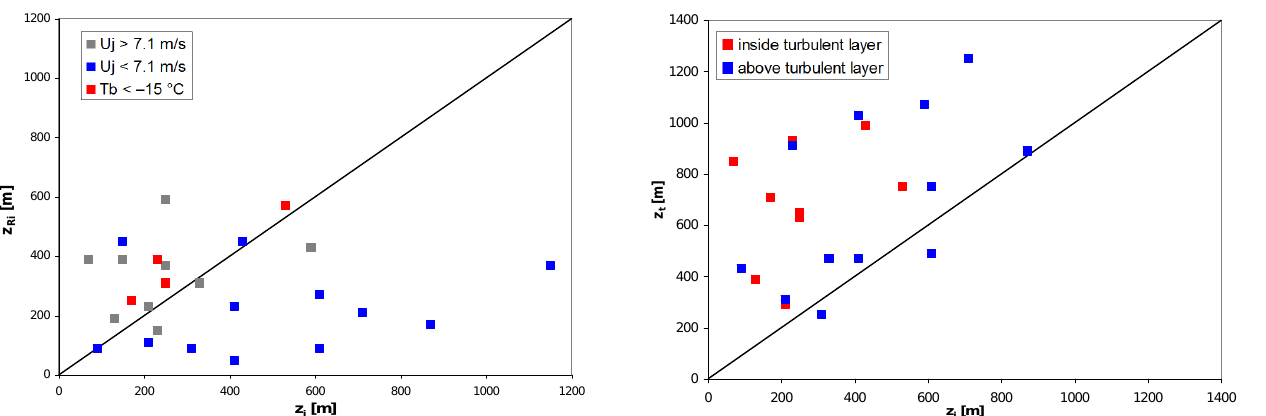
Fig. 8. A comparison of the height of the jet core, z j , with the height of temperature inversion top, z t . LLJs are divided into two groups with the core inside or outside the turbulent